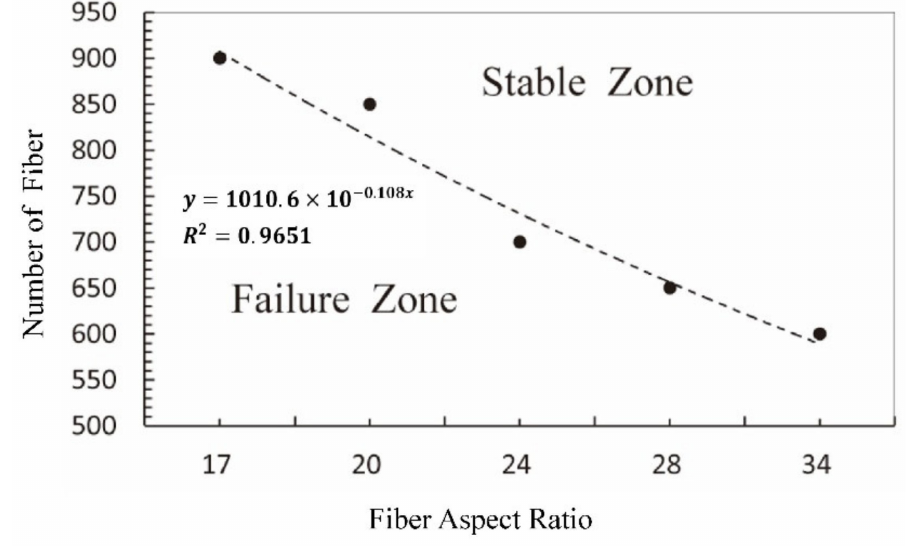
Figure 13. The fitting curve between the optimum amount of fiber and fiber aspect